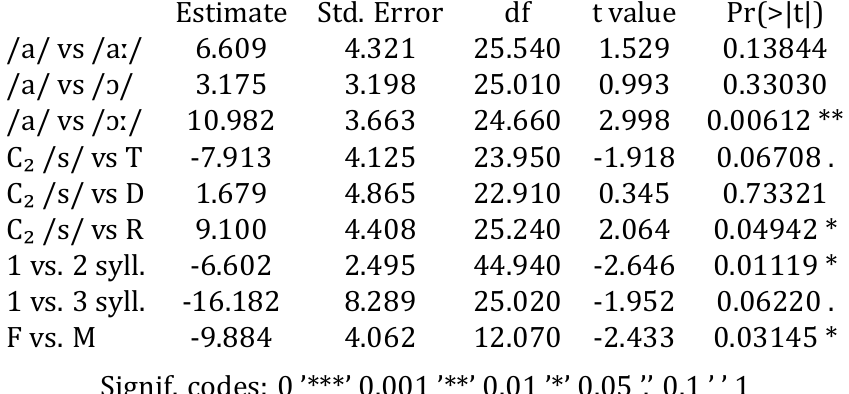
Table A.9: Post-aspiration occurrence of C₁ /s/ as a dependent vari-